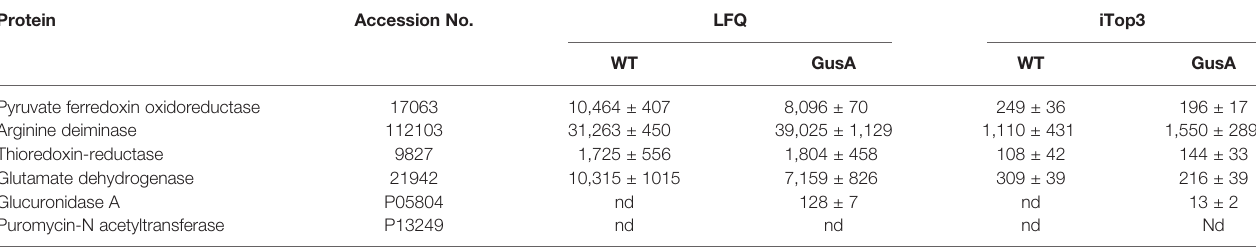
TABLE 1 | Major housekeeping proteins and transgenes in untransfected Giardia lamblia WBC6 wildtype (WT) and Escherichia coli glucuronidase A (GusA)-transfected trophozoites. Protein Accession